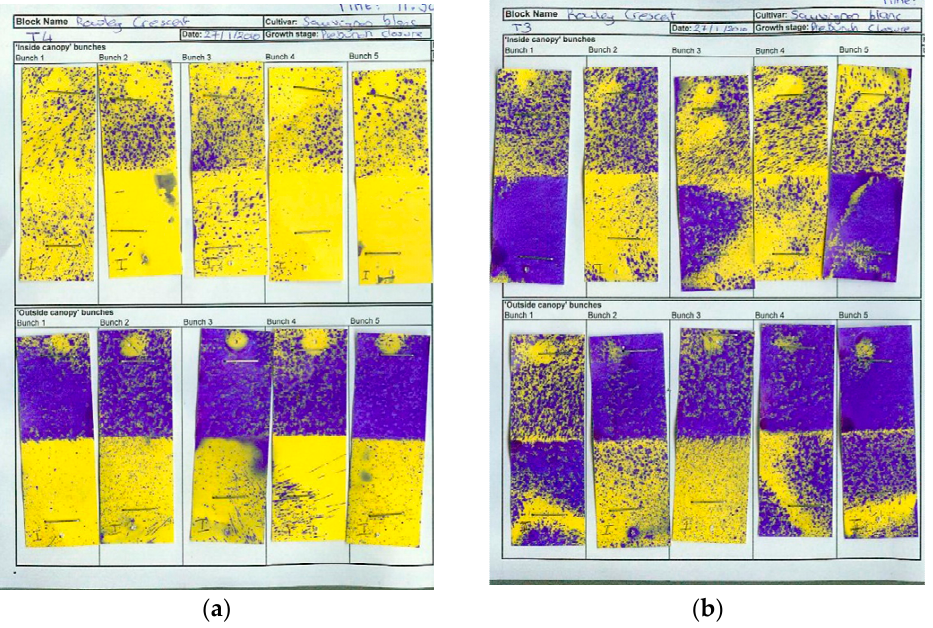
Figure 4. Moisture-sensitive papers indicating spray deposition in Marlborough, Season iii, under ( a ) standard canopy density (SCD), with approximately 26% bunch exposure; ( b ) low canopy density (LCD), with approximately 80% bunch exposure. The paper turns from yellow to purple when wet. The column of spray papers on the left-hand side in each picture indicates papers positioned on bunches on the outside of the canopy and the column on the right-hand side shows papers positioned on grape bunches inside the canopy.